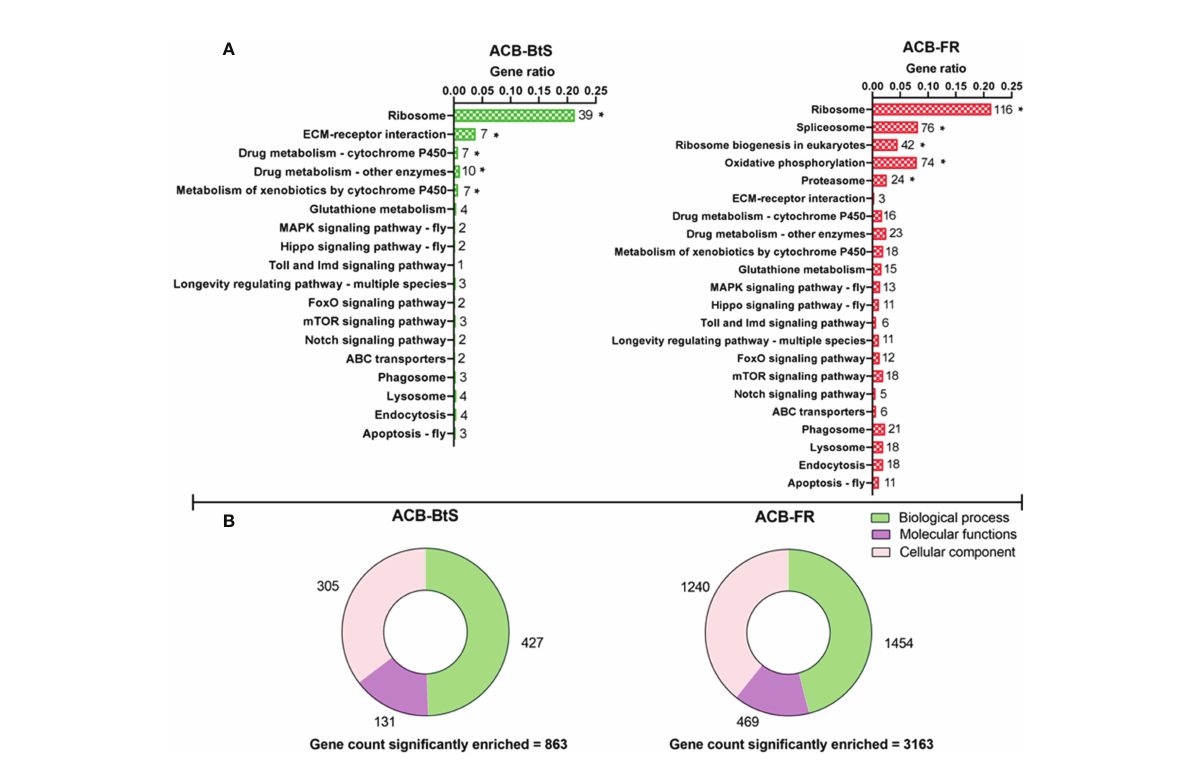
FIGURE 1 Differential gene expression after Cry1F treatment in hemocytes from susceptible (ACB-BtS) and Cry1F-resistant (ACB-FR) strains of Asian corn borer. (A) Hemocyte sample processing and enriched genes grouped after KEGG analysis. The numbers shown on the right side of every horizontal bar represent the number of genes involved in that speci fi c pathway. Asterisks represent signi fi cant enrichment of genes in the hemocytes of Cry1F- treated ACB-BtS and ACB-FR larvae compared with respective non-treated controls (Student ’ s t -test, P <0.05). (B) Gene Ontology analysis shows the number of signi fi cantly enriched genes in the hemocytes of Cry1F treated ACB-BtS and ACB-FR larvae compared to respective non-treated controls (Student ’ s t-test, P